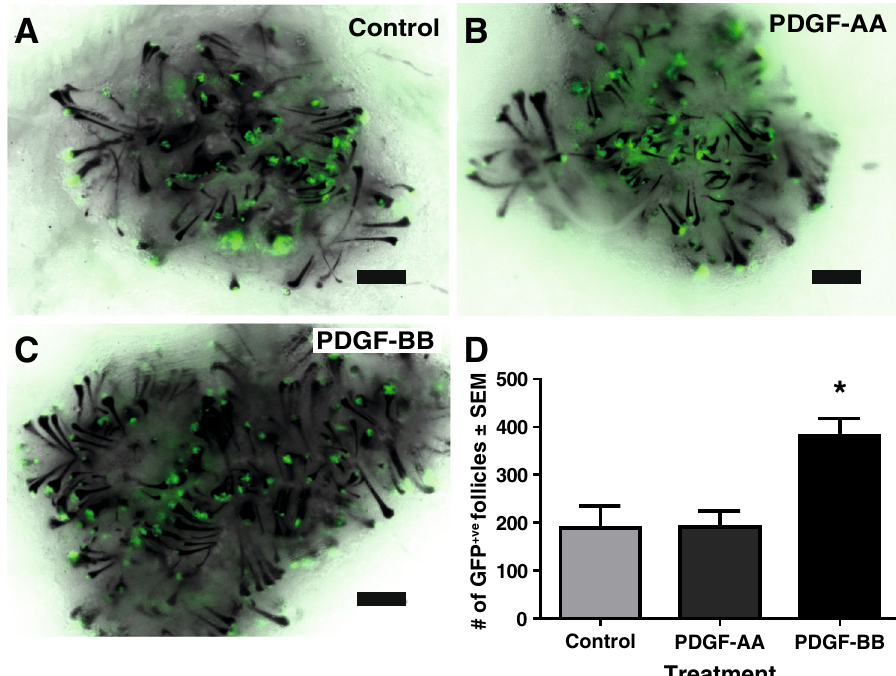
Fig. 5 Exposure to PDGF-BB promotes enhanced inductive capacity of adult rat SKPs. Primary adult GFP-expressing rat SKPs were grown in the absence (control) or the presence of 50 ng/ml rat PDGF-AA or PDGF-BB. After one passage, SKPs colonies were dissociated to single cells and combined with epidermal aggregates (500,000 rat SKPs combined with 10,000 P0 mouse epidermal aggregates) and injected subcutaneously. Hair follicles were harvested and quanti fi ed 2 weeks post transplantation. Images show representative grafts from a control, b PDGF-AA, and c PDGF-BB. d Quanti fi cation of GFP +ve HFs within each graft. Data represent three independent replicates, with a total of 4 – 6 grafts per group. Data were analyzed by one-way ANOVA. Asterisk denotes p ˂ 0.05. Scale bars represent 500